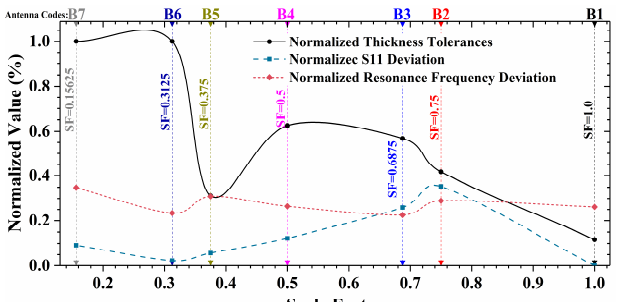
Figure. 9. Thickness tolerances and its effect to f r and its S 11